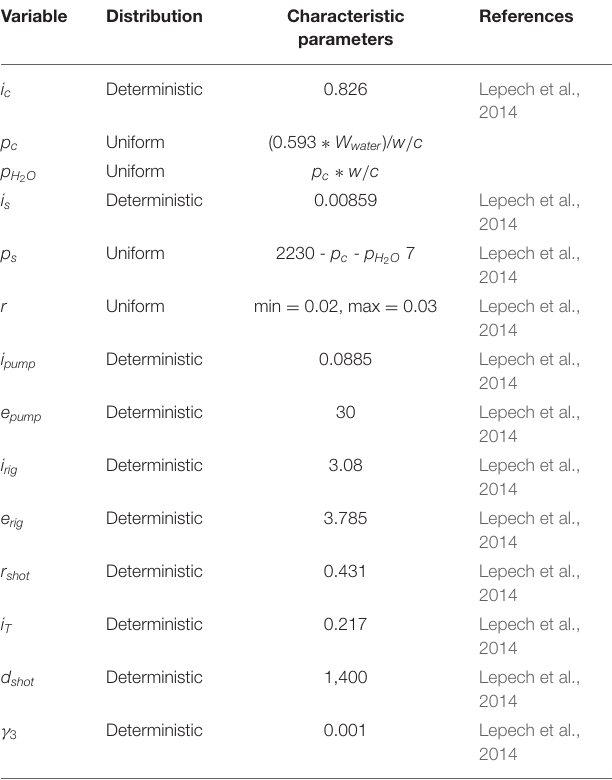
TABLE 4 | Hydrodemolition environmental impact modeling variables, distributions, and parameters. Variable